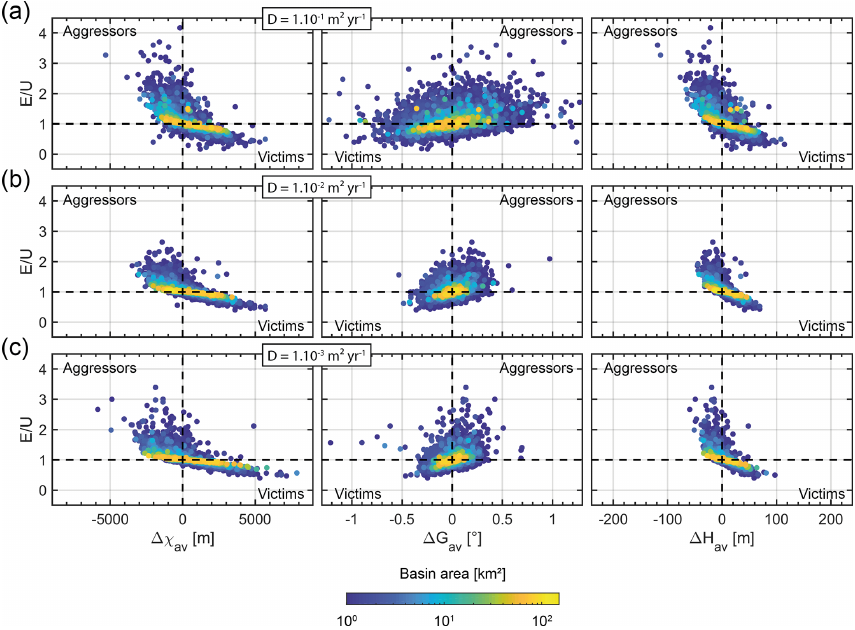
Figure 10. Effect of diffusivity. Colour scale indicates basin area. Basins of variable sizes are sorted into seven area classes expanding geometrically with a multiplying factor of 2 from 1–2 to 64–128km 2 , every 0.5Myr over the time period 5–10Myr. Basins with a confidence index lower than 50% are discarded from the analysis. (a) Results with a diffusivity of 10 − 1 m 2 yr − 1 . (b) Results with a diffusivity of